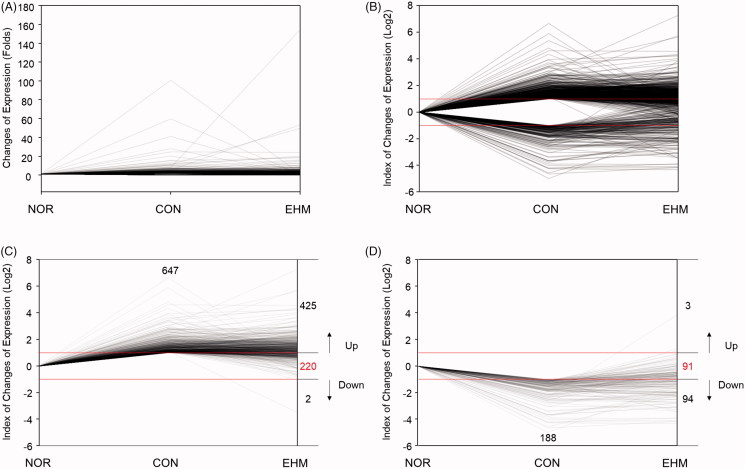
Line plot of alterations in liver gene expression in hyperlipidemic mice. Raw fold values (A) for gene expression compared with that in the NOR group were converted to log values (B) for each differentially expressed gene, and the numbers of up-regulated (C), down-regulated (D), and restored (C, D) genes were reported. NOR: normal diet-fed control mice, CON: HFD-fed hyperlipidemic mice, EHM: HFD-fed and EHM-administered mice.